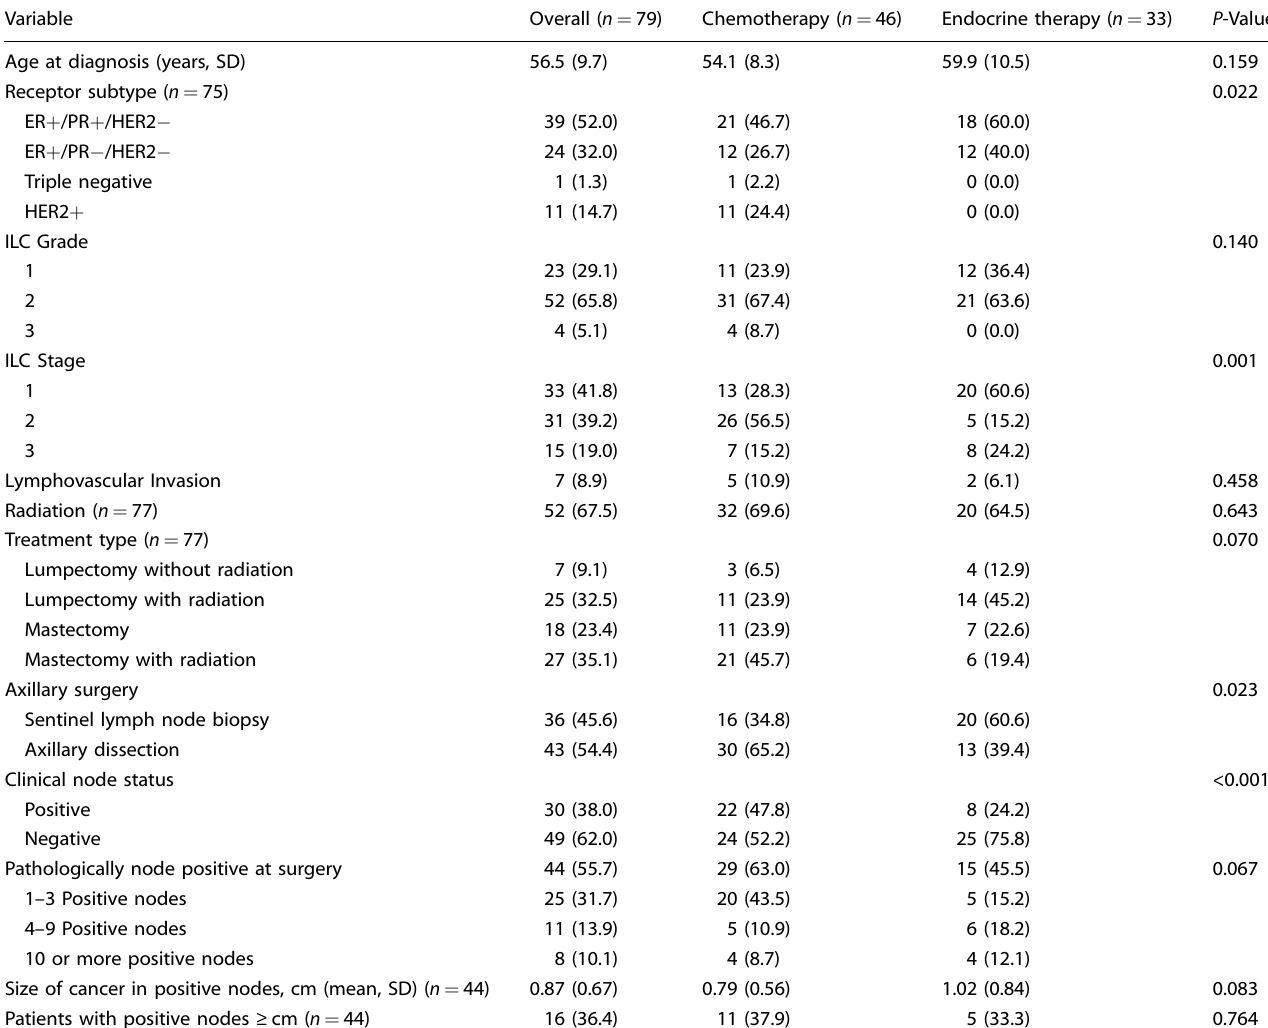
Table 1. Patient and tumor characteristics.